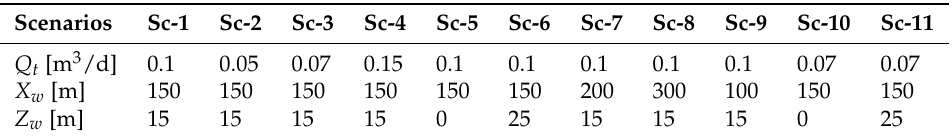
Table 3. Parameters for different scenarios.